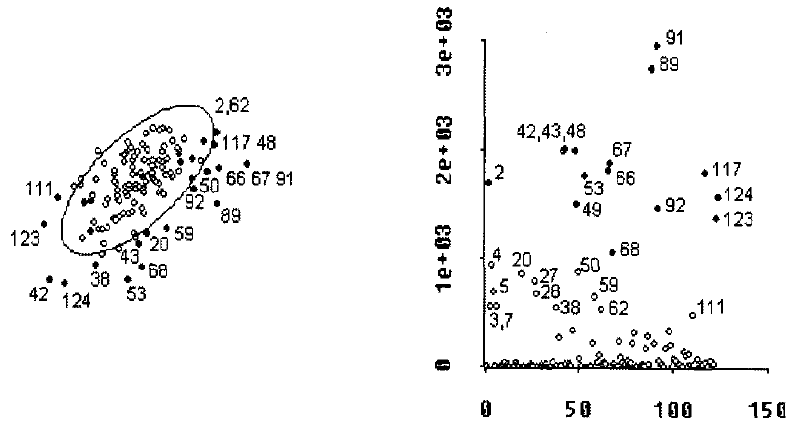
A snapshot grand tour the of concentracion. Left: An point projections with superimposed. Right: A linked count-plot times data point was notified the